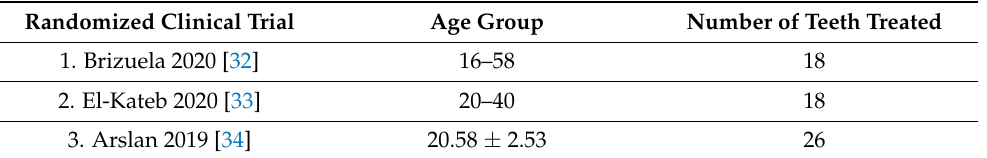
Table 4. Randomized Clinical Trials where REP in adult permanent mature teeth were performed, according to age group and number of teeth